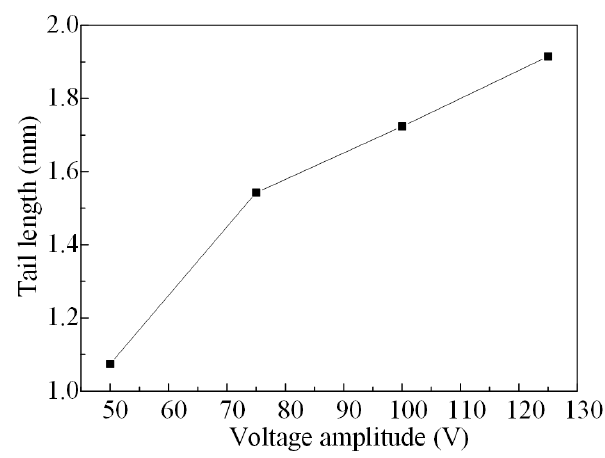
Figure 7. The tail length varies with different voltage amplitudes.